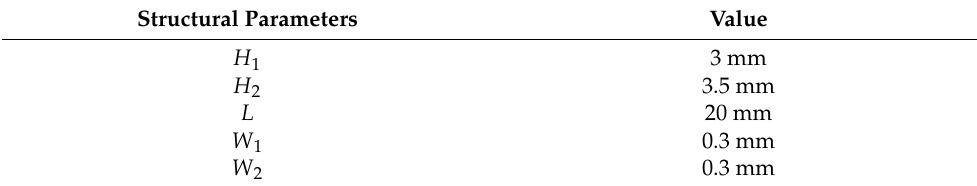
Table 1. ECB cathode tool structural